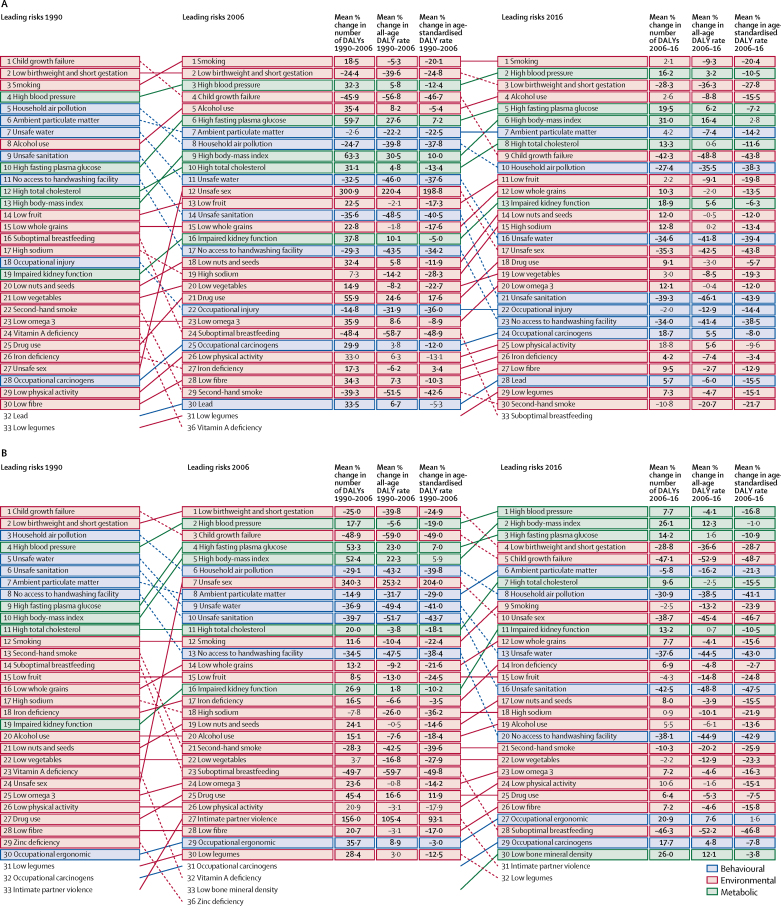
Leading 30 Level 3 risk factors by attributable DALYs at the global level, 1990, 2006, and 2016, for males (A) and females (B)Risks are connected by lines between time periods. Behavioural risk factors are shown in red, environmental risks in blue, and metabolic risks in green. For the time period of 1990 to 2006 and for 2006–16, three measures of change are shown: percent change in the number of DALYs, percent change in the all-age DALY rate, and percent change in the age-standardised DALY rate. Statistically significant increases or decreases are shown in bold (p<0·05). DALYs=disability-adjusted life-years.